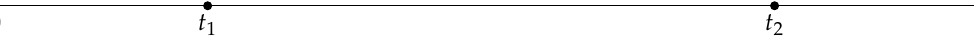
Figure 1. The number of failed comments is exactly r ( < i < n ) at time t 1 ( > 0 ) , and the system failed at time t 2 ( > t 1 )